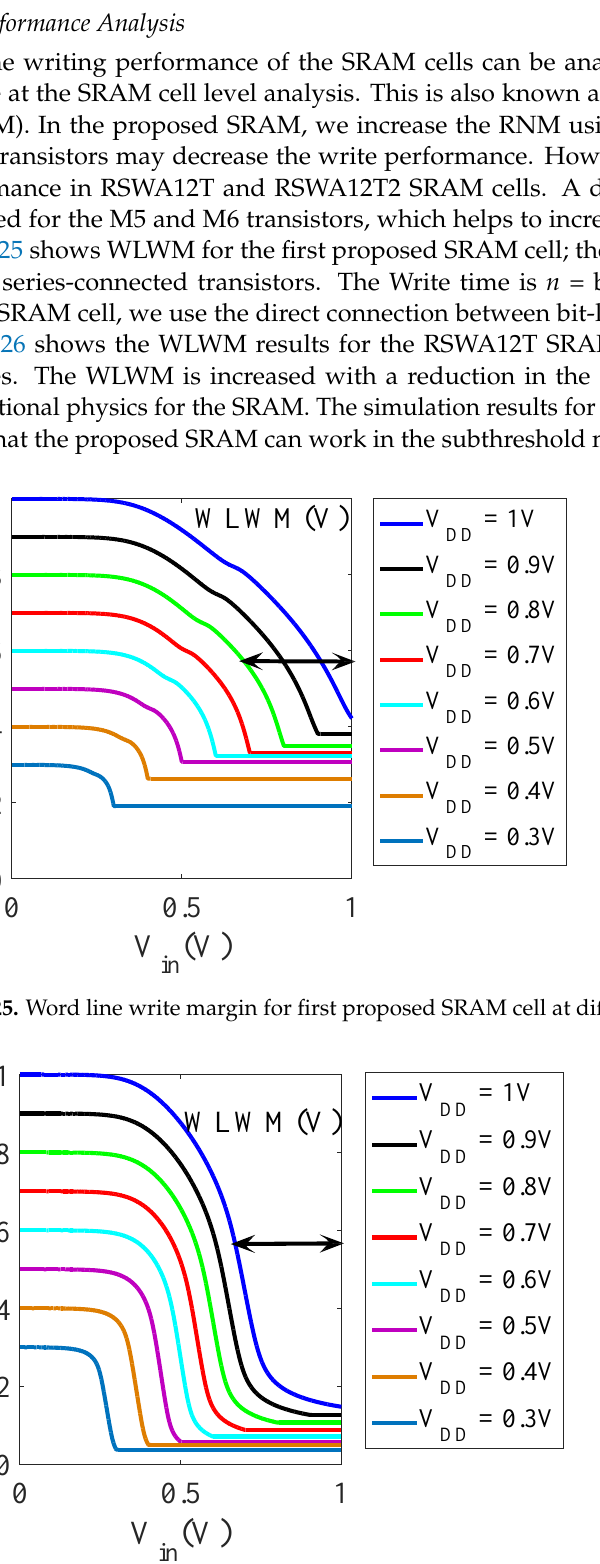
Figure 26. Word line write margin for second proposed SRAM cell at different supply